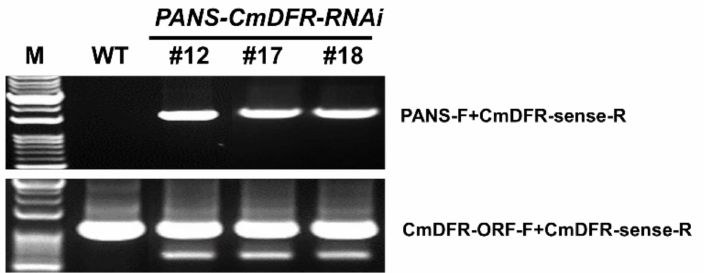
Figure 3. Genomic PCR analysis verified that transgenes were stably transferred into stem cuttings. DNA from wild-type (WT) and transgenic chrysanthemum plants with PANS-CmDFR-RNAi were subjected to amplification reactions using a primer set (PANS-F and CmDFR-sense-R) for the confir- mation of the presence of the transgene. Primers amplifying the endogenous CmDFR gene were used as an internal control for chrysanthemum genomic DNA. M: DNA size marker of 1 Kb plus 100 bp DNA ladder.